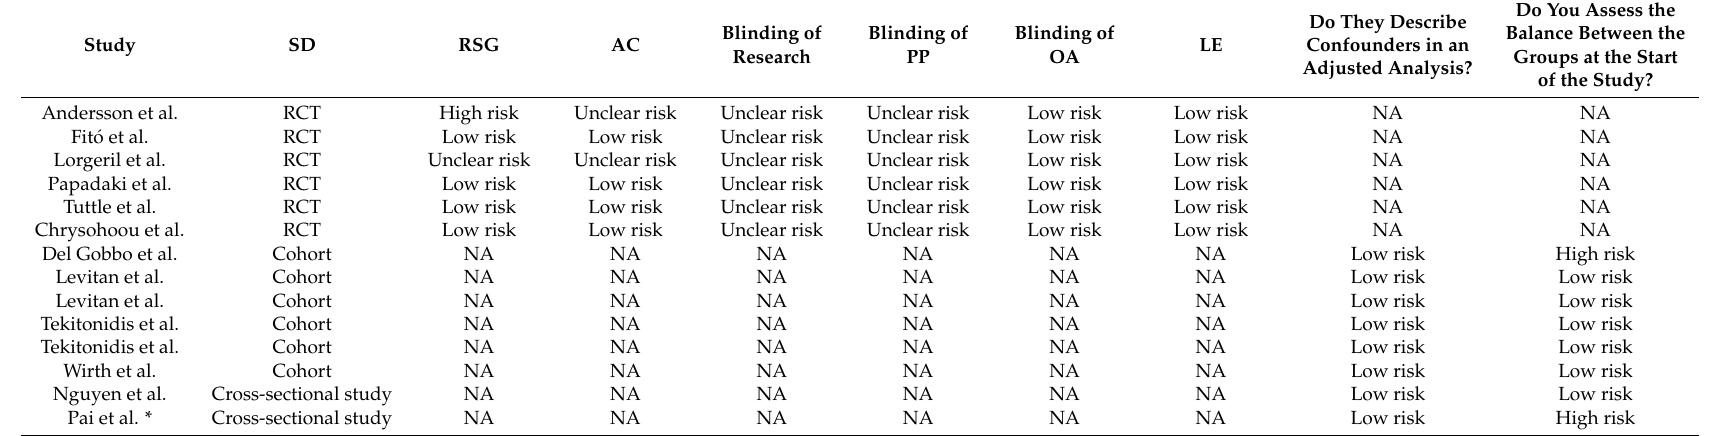
Table 2. Quality assessment of